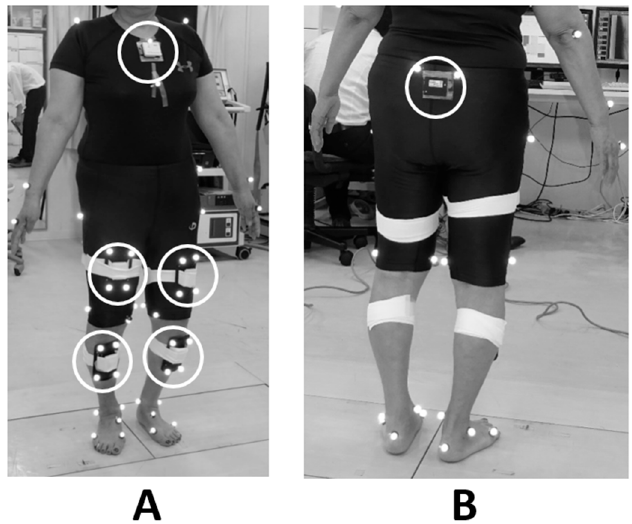
Figure 1. Placement of retro-reflective markers and the inertial measurement unit. ( A ) Front side and ( B ) Back side.